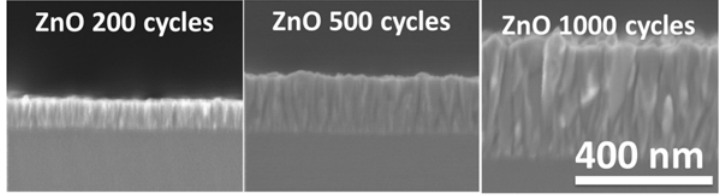
Figure 6. SEM image of ALD ZnO nanolayers with 200, 500 and 1000 cycles.